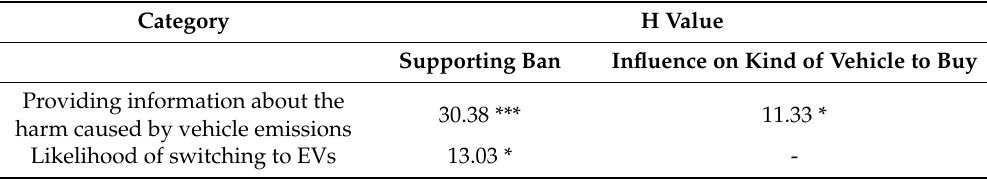
Table 2. Kruskal–Wallis H test